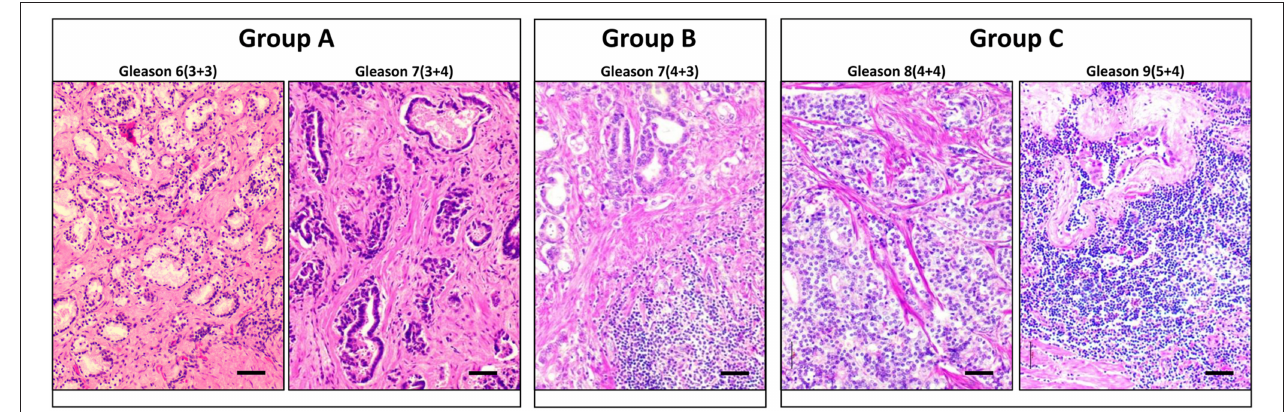
FIGURE 1 | Representative H and E staining of PCa tissue sections that represent each of the three Gleason groups. Cross-sections of PCa tissues representing each of the three Gleason groups are stained with H and E. Left panel represents group A that includes Gleason scores 6 and 7(3 + 4). Middle panel represents Group B that includes Gleason score 7(4 + 3). Right panel represents group C that includes Gleason scores 8 and 9. Scale bars = 50 µ